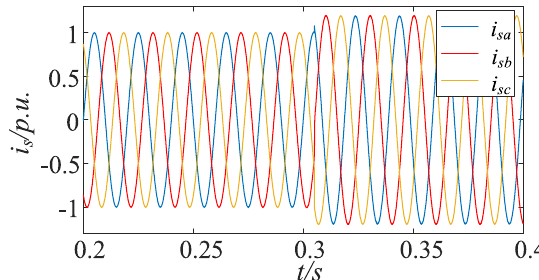
Fig. 20 Three-phase grid-connected current when the voltage drops under full load condition